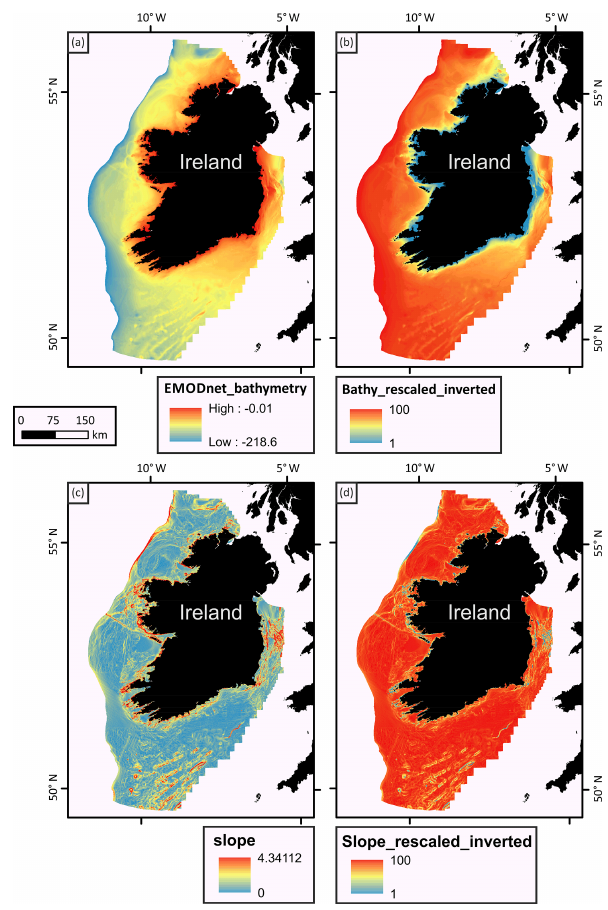
Figure 4. Bathymetry and slope modelling, rescaling, and inver- sion results. (a) Original EMODnet bathymetric data. (b) Rescaled and inverted bathymetric data, modelled to estimate the influence of depth and distance from shore on sediment stability. (c) Slope calculation results. (d) Rescaled and inverted slope